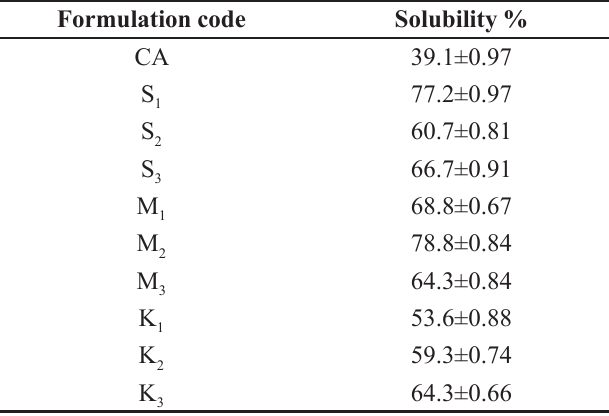
TABLE V - Solubility of CA and its formulations Formulation